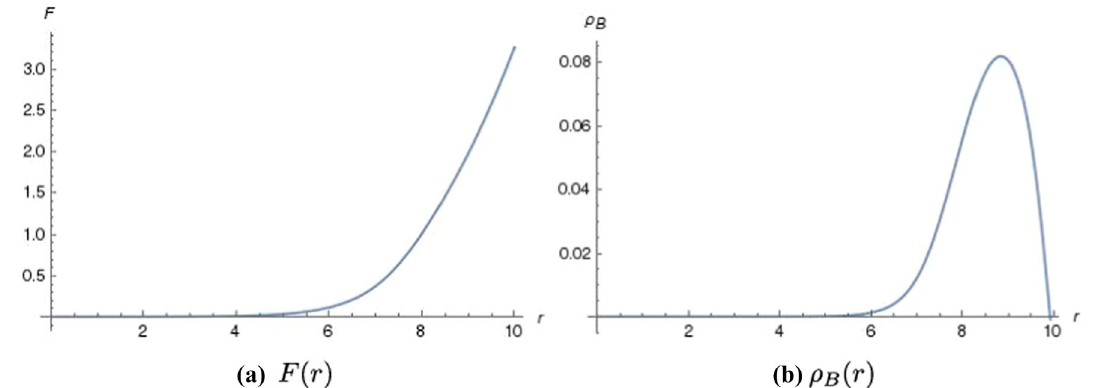
Fig. 1 Solution with n = 0